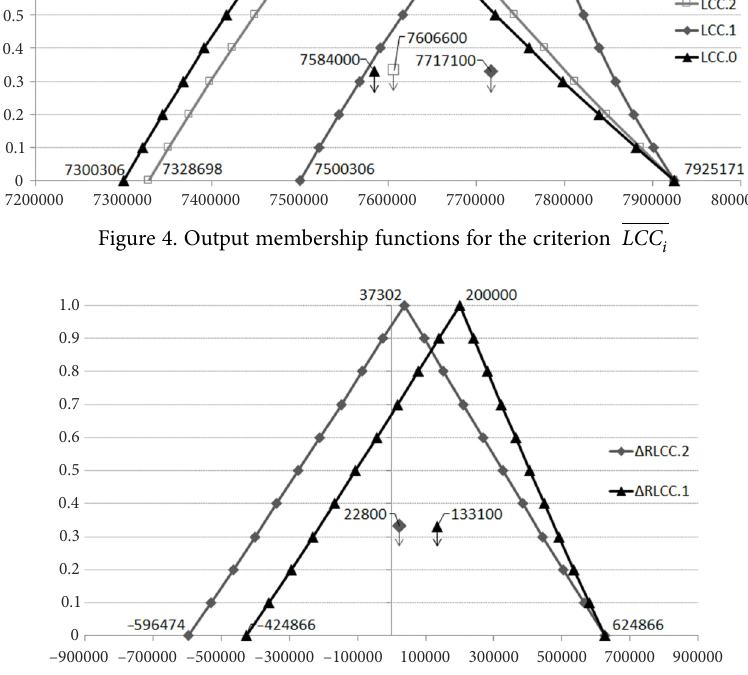
Figure 5. Output membership functions for the